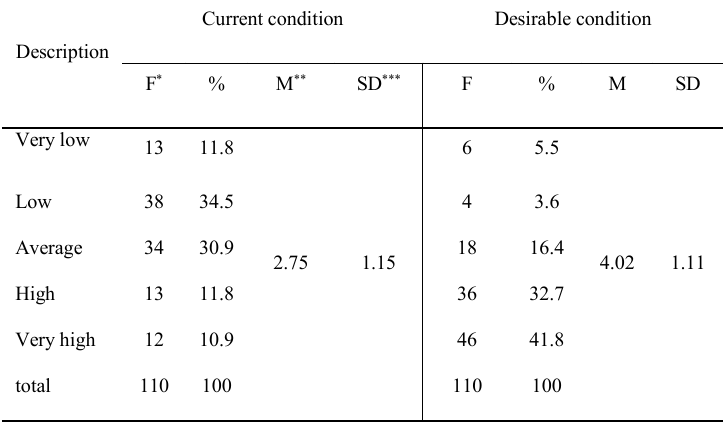
Table 5: Relative distribution of respondents according to their view of the role of the total index of physical factors in restoring and conserving the historic textures of Tehran